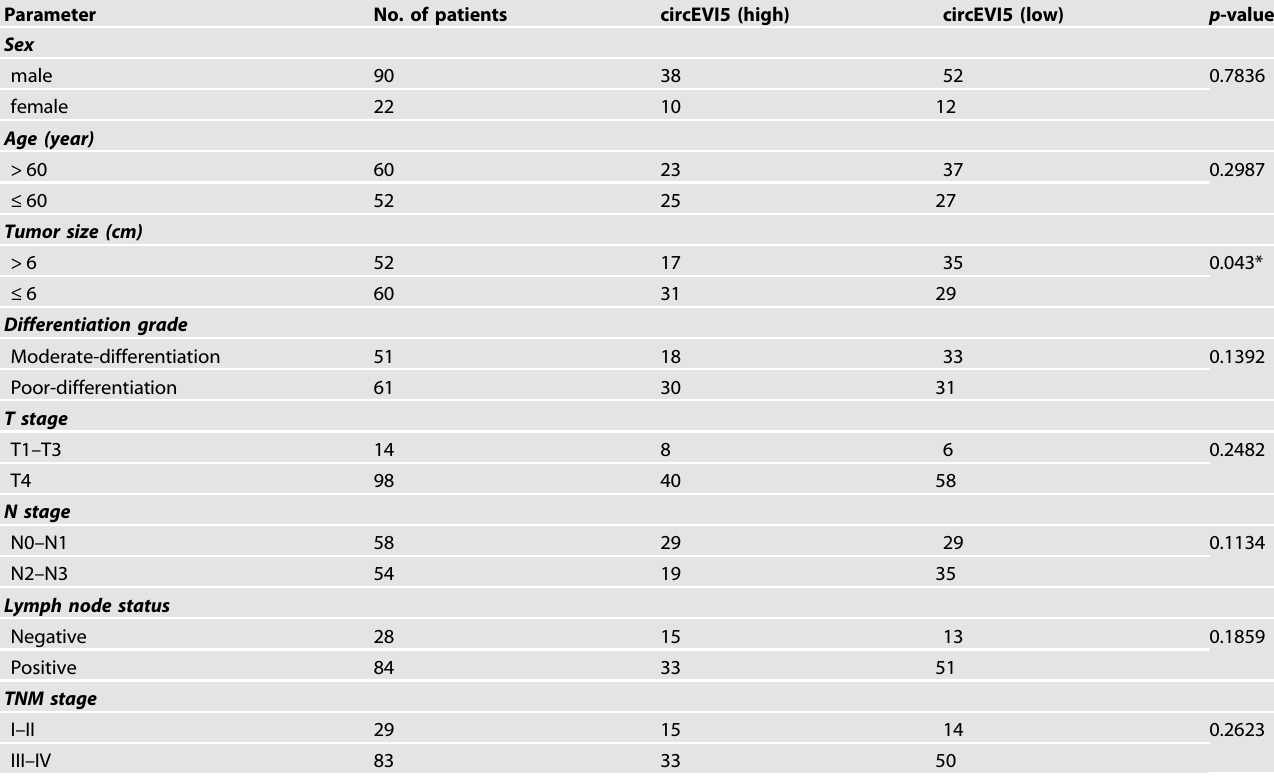
Table 1. Relationship between circEVI5 expression and clinicopathologic factors of patients with gastric cancer.